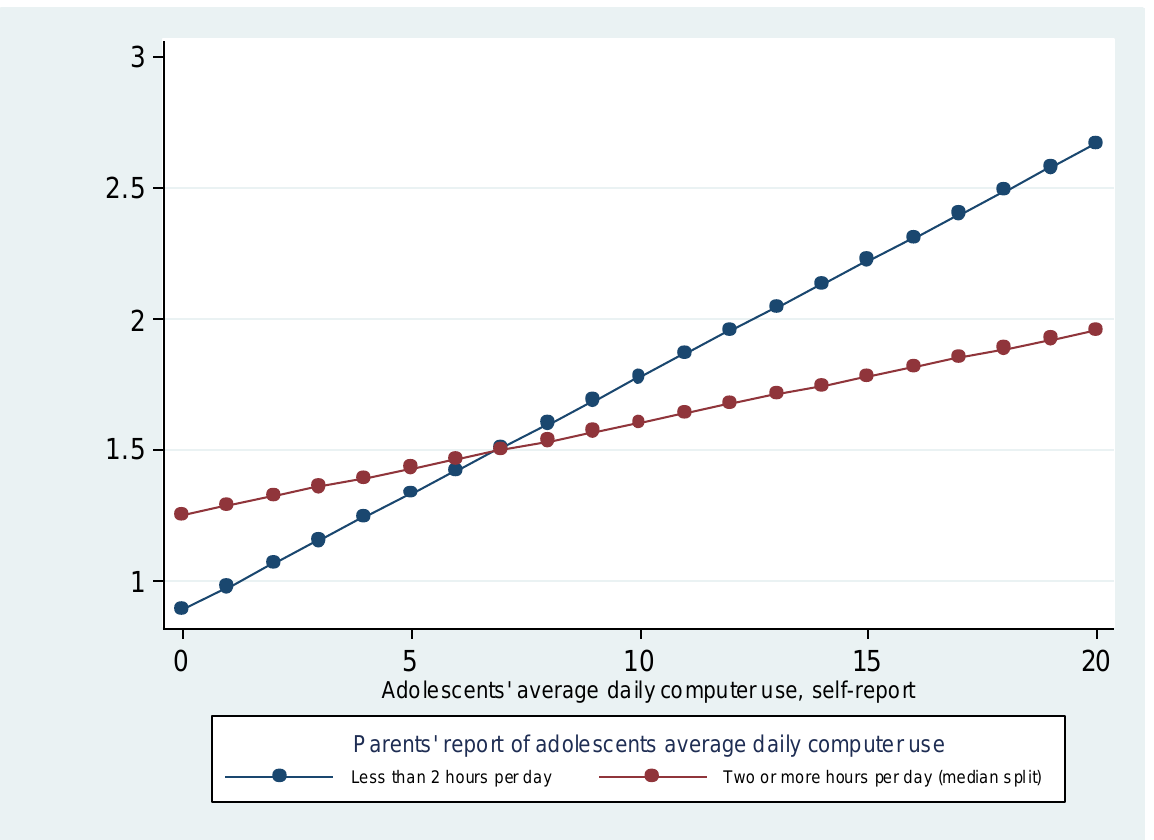
Figure 2. Interaction of parent and adolescent time estimates of computer use on problematic internet use. Note: A median split is used for graphing purposes. Both variables were treated as continuous in the interaction term. This graph is based on unweighted